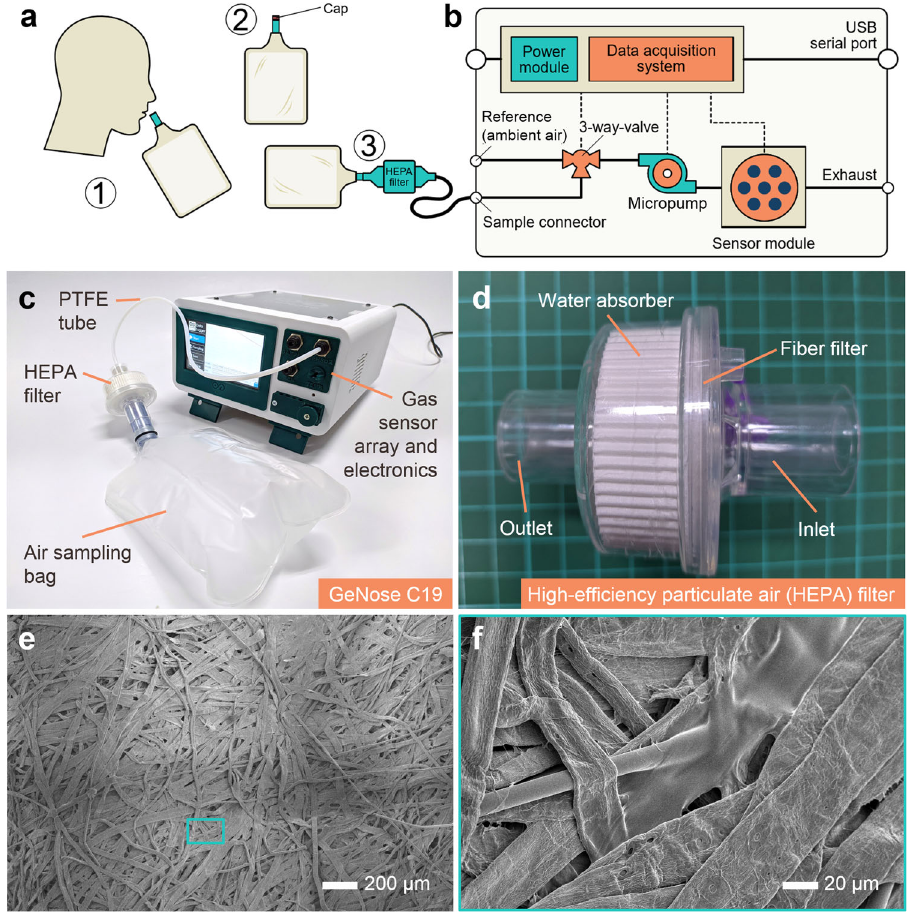
Fig. 2 Integrated GeNose C19 system and its components. a Scheme of the off-line breath sampling pipeline for GeNose C19: (1) air inhaled through the nose and subsequently exhaled through the mouth to a sampling bag, (2) sealing or closing of the sampling bag cap to avoid the collected air leakage, and (3) direct plugging of the sampling bag into the electronic nose inlet (sample connector). b Diagram and c photograph of GeNose C19 integrated with a high-ef fi ciency particulate air (HEPA) fi lter and an air sampling bag through a fl exible medical- grade polytetra fl uoroethylene (PTFE) tube with an outer diameter of 4 mm. The electronic nose consists of several main electronic and mechanical parts (i.e., power module, data acquisition system, 3-way-valve, micropump, and sensor module inside the sealed gas chamber). The sensor module comprises 10 different sensing devices arranged as an array. d HEPA fi lter for fi ltering out the particulate matters and trapping the SARS-CoV-2 available from the exhaled breath of a patient con fi rmed with positive COVID-19. e , f Scanning electron micrographs of the fi ber fi lter used in the GeNose C19- fi ltering